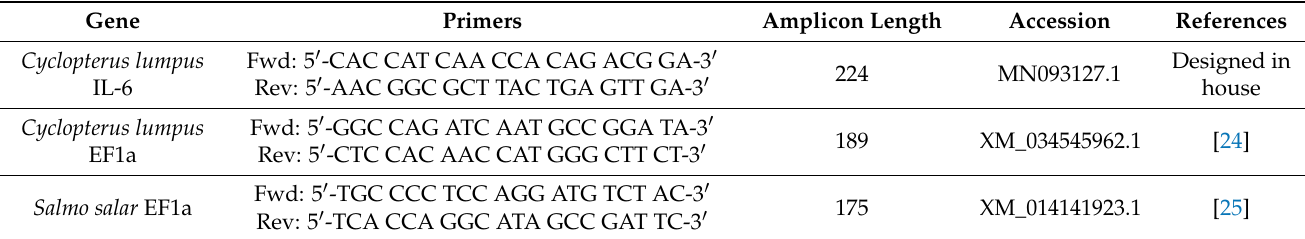
Table 1. Primer over view; species